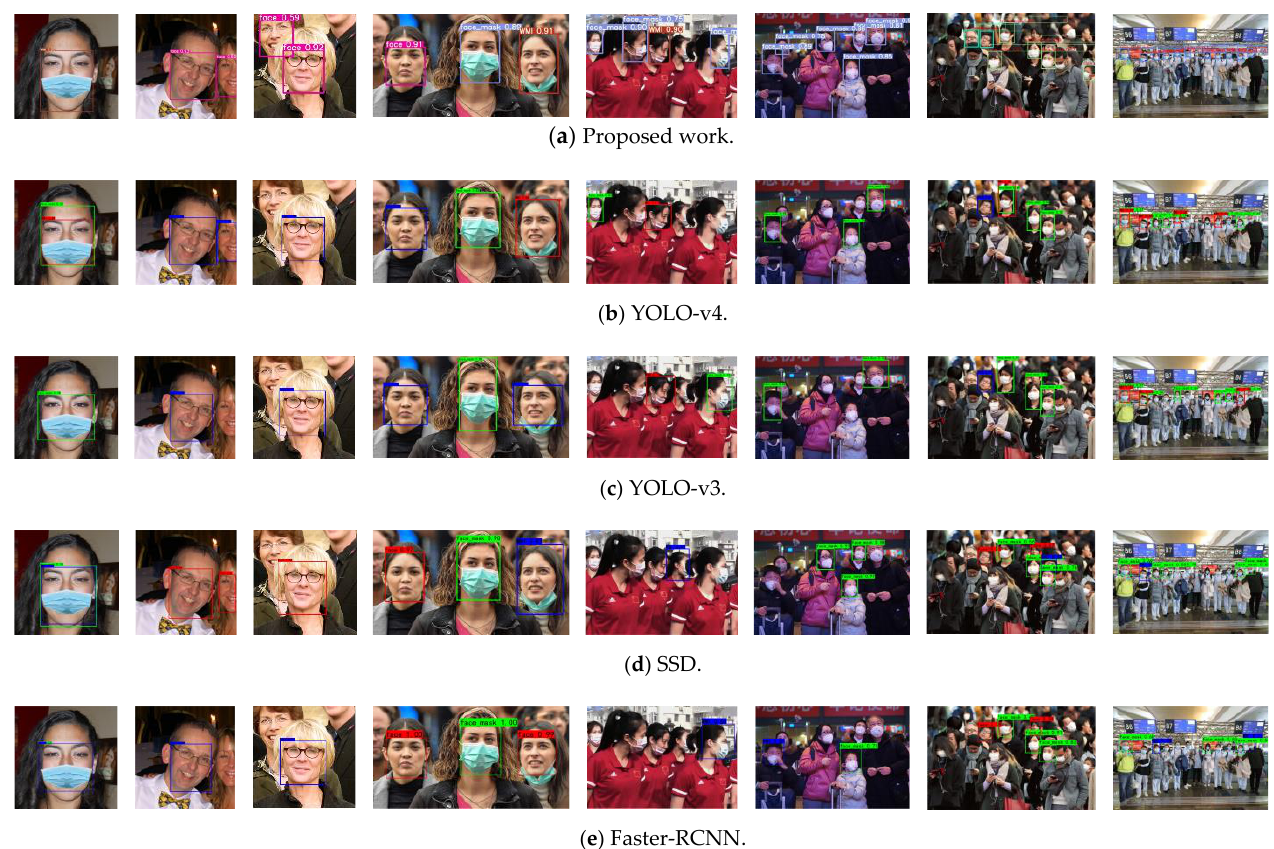
Figure 12. Visualization of different models in performance testing.